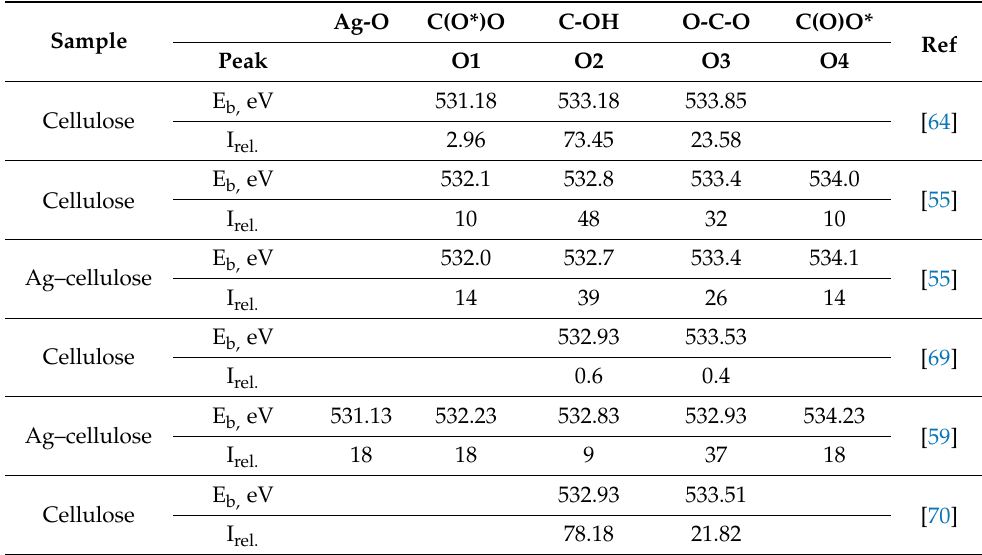
Table 2. Characteristics of the O 1s photoelectron spectra: binding energies (E b ) and relative intensities (I rel ) of photoelectron peaks assigned to different chemical groups.